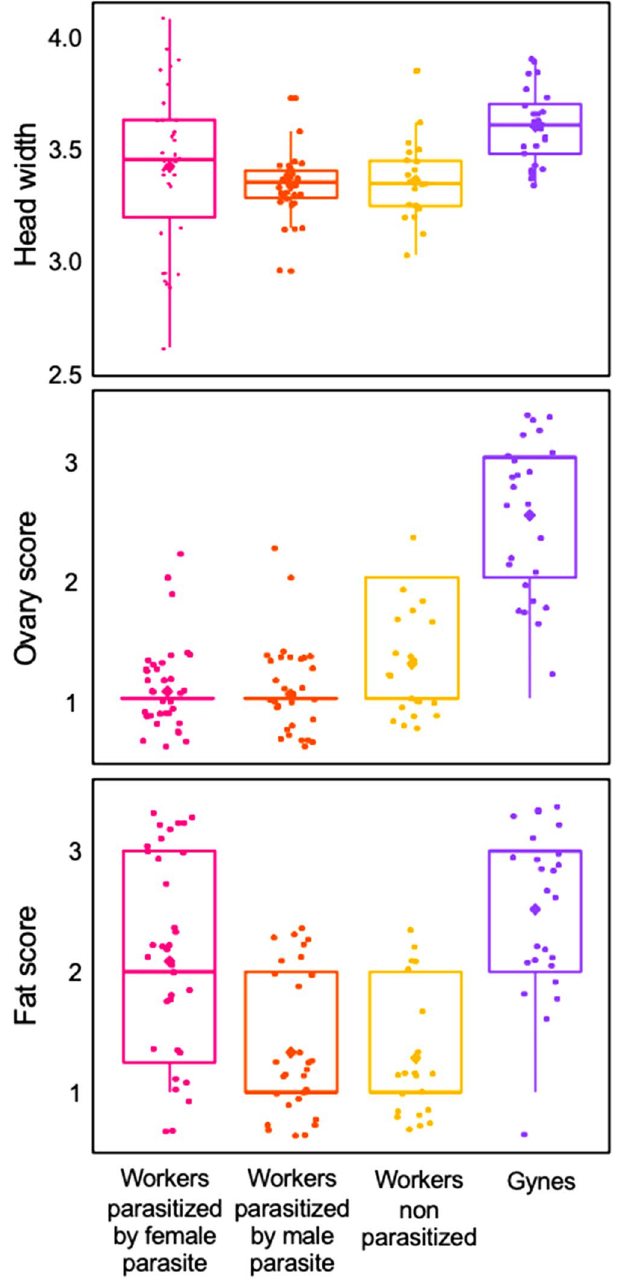
Figure 2. Head width (in mm), ovary score and fat score of workers parasitized by female or male parasites, non-parasitized workers and gynes. The boxplots show medians, quartiles, 5th and 95th percentiles and minimum and maximum values outside of the percentiles (color dots); diamonds represent means; points jittered to prevent